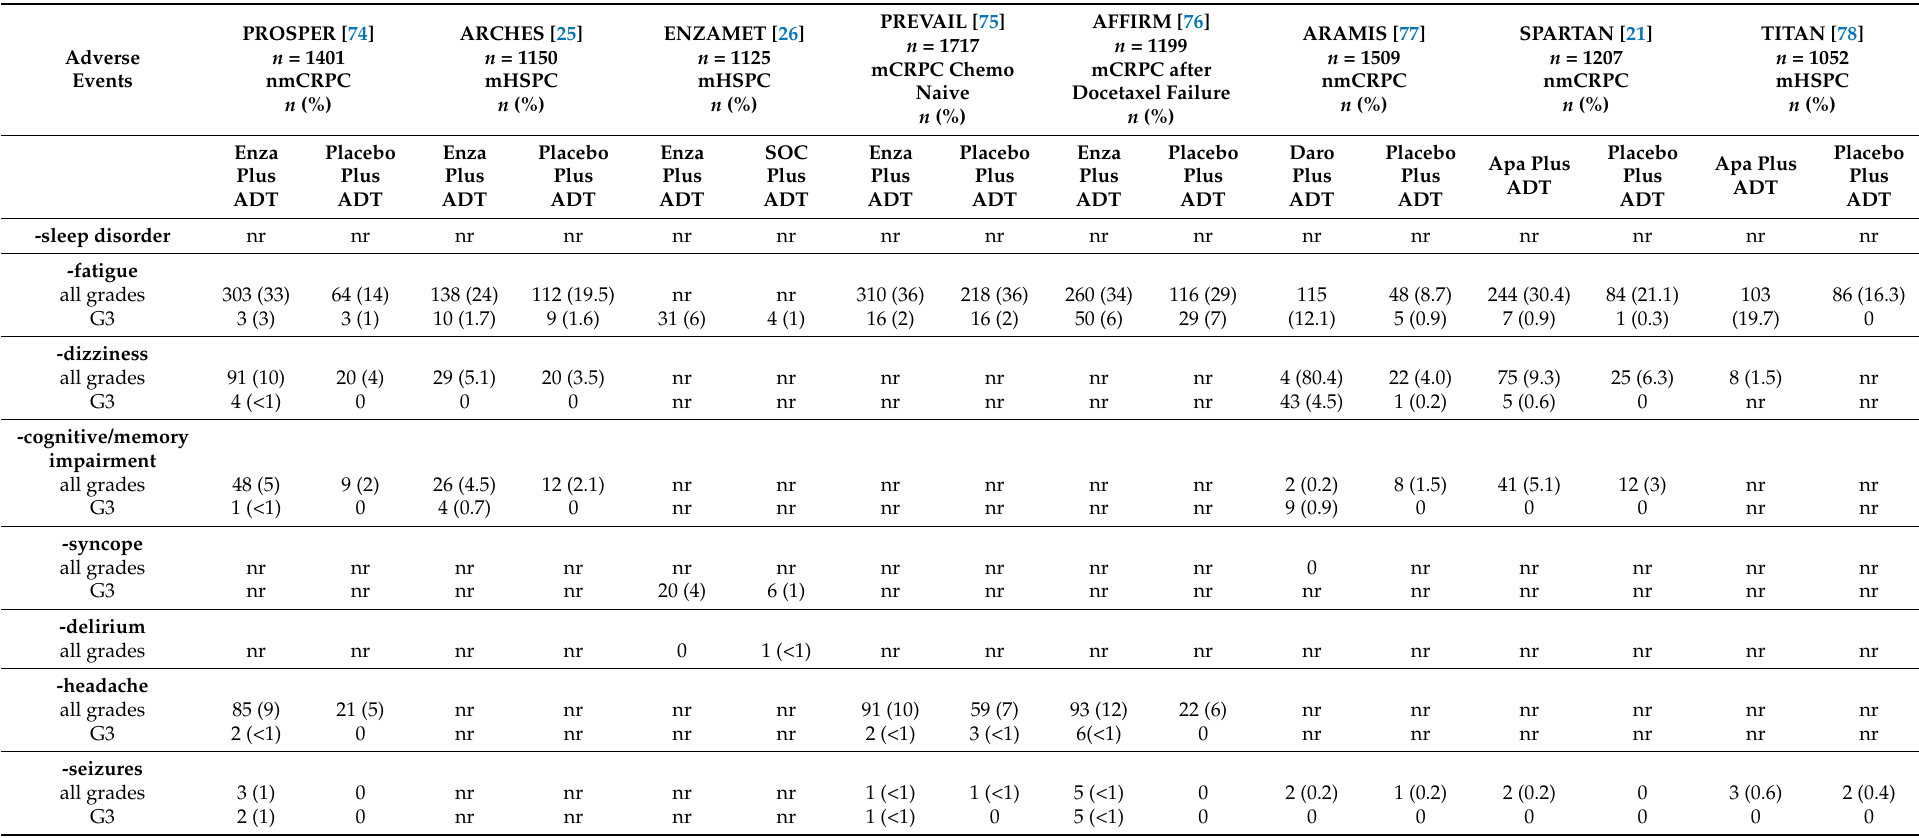
Table 2. Phase III trials including second-generation NSAA (Enzalutamide, Darolutamide, Apalutamide) reporting neurological adverse events of interest for sleep